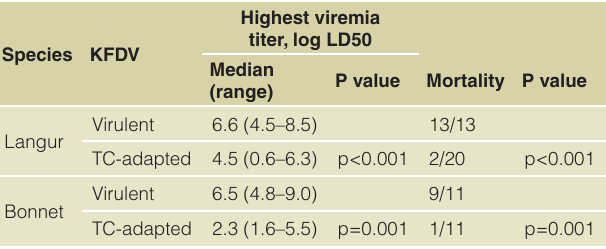
Table 5. Summary of viremia and mortality data of virulent and TC-adapted KFDV in langur and bonnet monkeys. *One value for each animal, underlined in Table 1–Table 4.